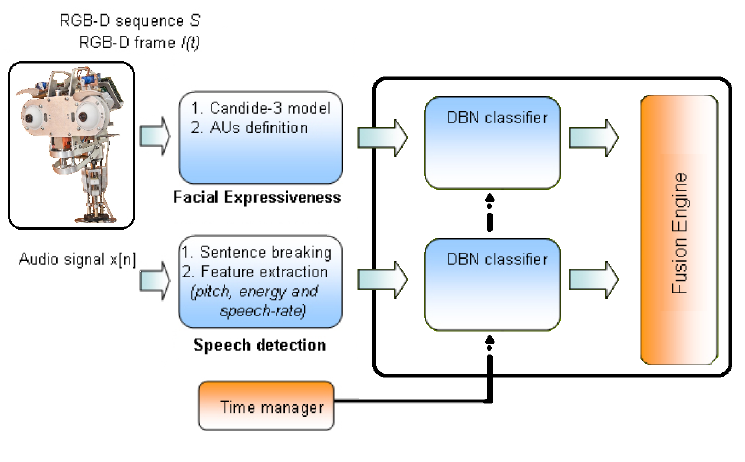
Figure 10. Overview of the multimodal emotion recognition system described in this work.